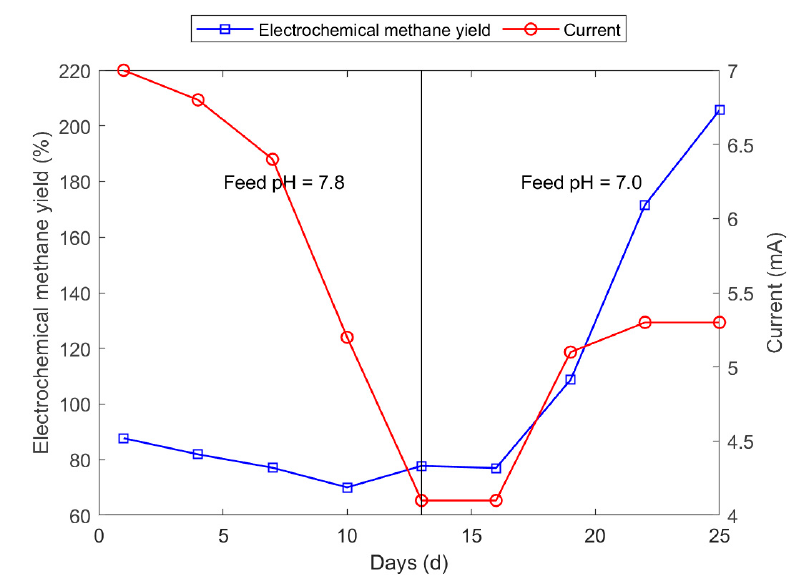
Figure 6. Electrochemical methane yield and currents production with respect to feed pH.